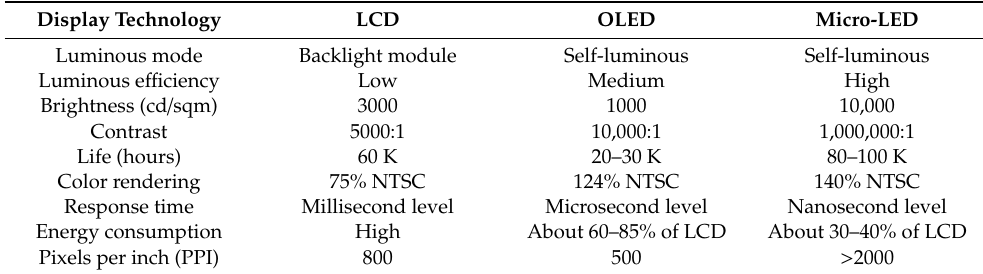
Table 1. Performance comparison of micro-light-emitting diodes (micro-LEDs) with liquid-crystal displays (LCD) and organic light-emitting diodes